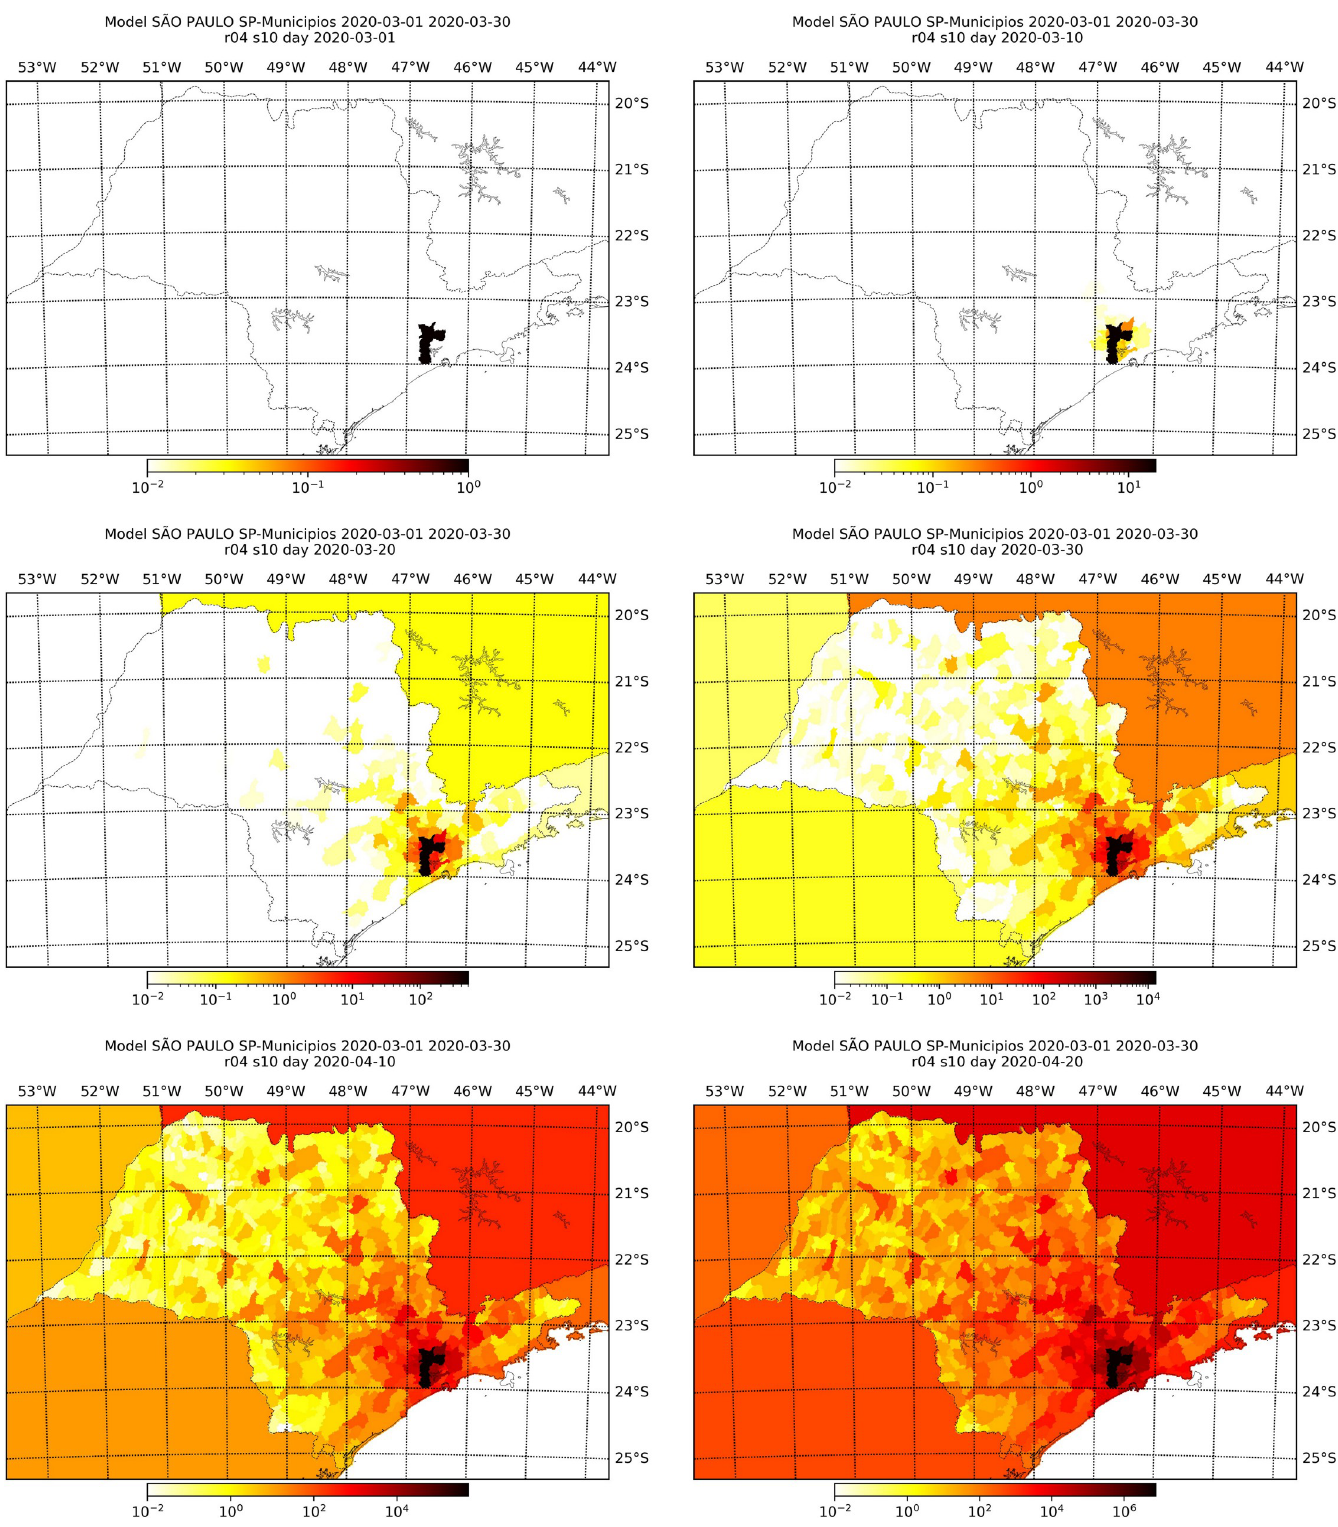
Fig 6. Simulation results for the number of infected individuals in the state of S ã o Paulo for selected days assuming s = 1. The maps refer, respectively, to March 1 st , 10 th , 20 th and 30 th , and April 10 th and 20 th .